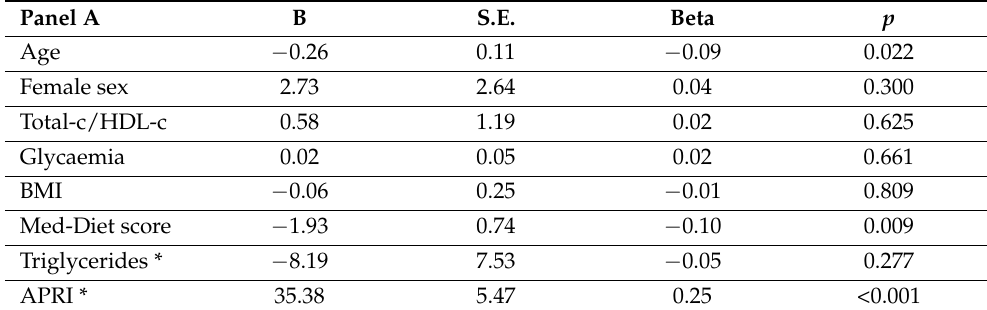
Table 2. Multivariate linear regression analysis of factors associated with TxB 2